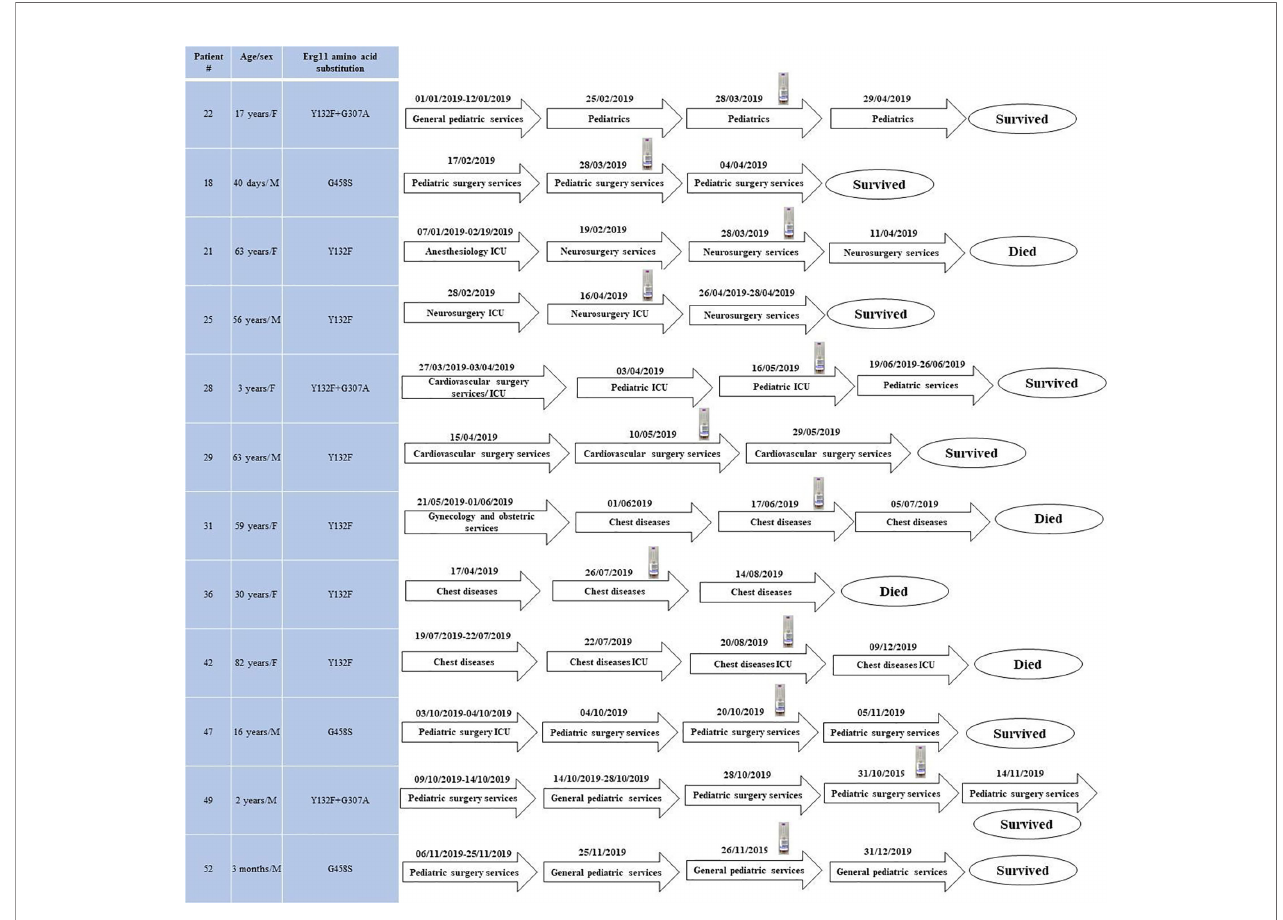
FIGURE 4 | The transmission map of patients infected with fl uconazole non-susceptible clonal isolates and/or with those showing high genetic similarity during the study period. Blood bottle symbol denotes the positive blood bottle